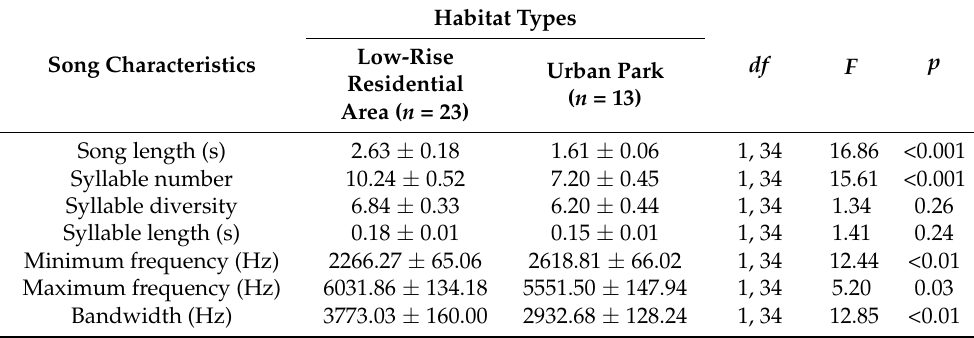
Table 1. Song characteristics of oriental magpie-robins analyzed between low-rise residential areas and urban parks (data are shown as the mean ±